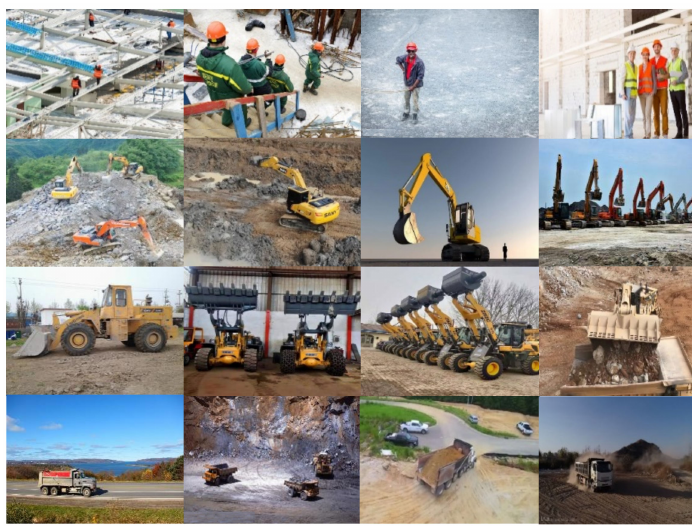
Figure 5. Partial dataset example.